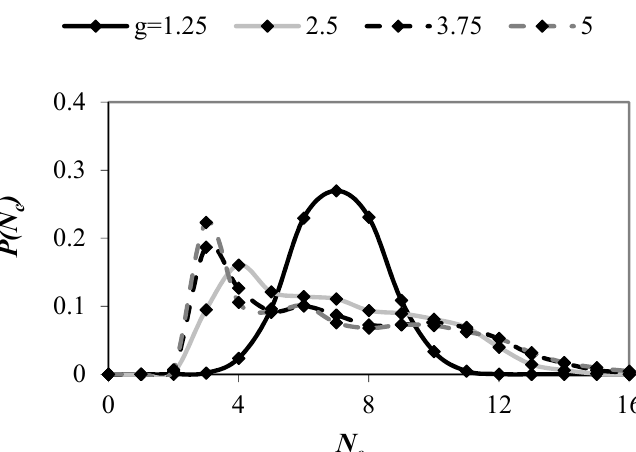
Figure 6. Probability distributions for the number of contacts per particle in mixtures with PSD uniform by number of spheres and various values of g.